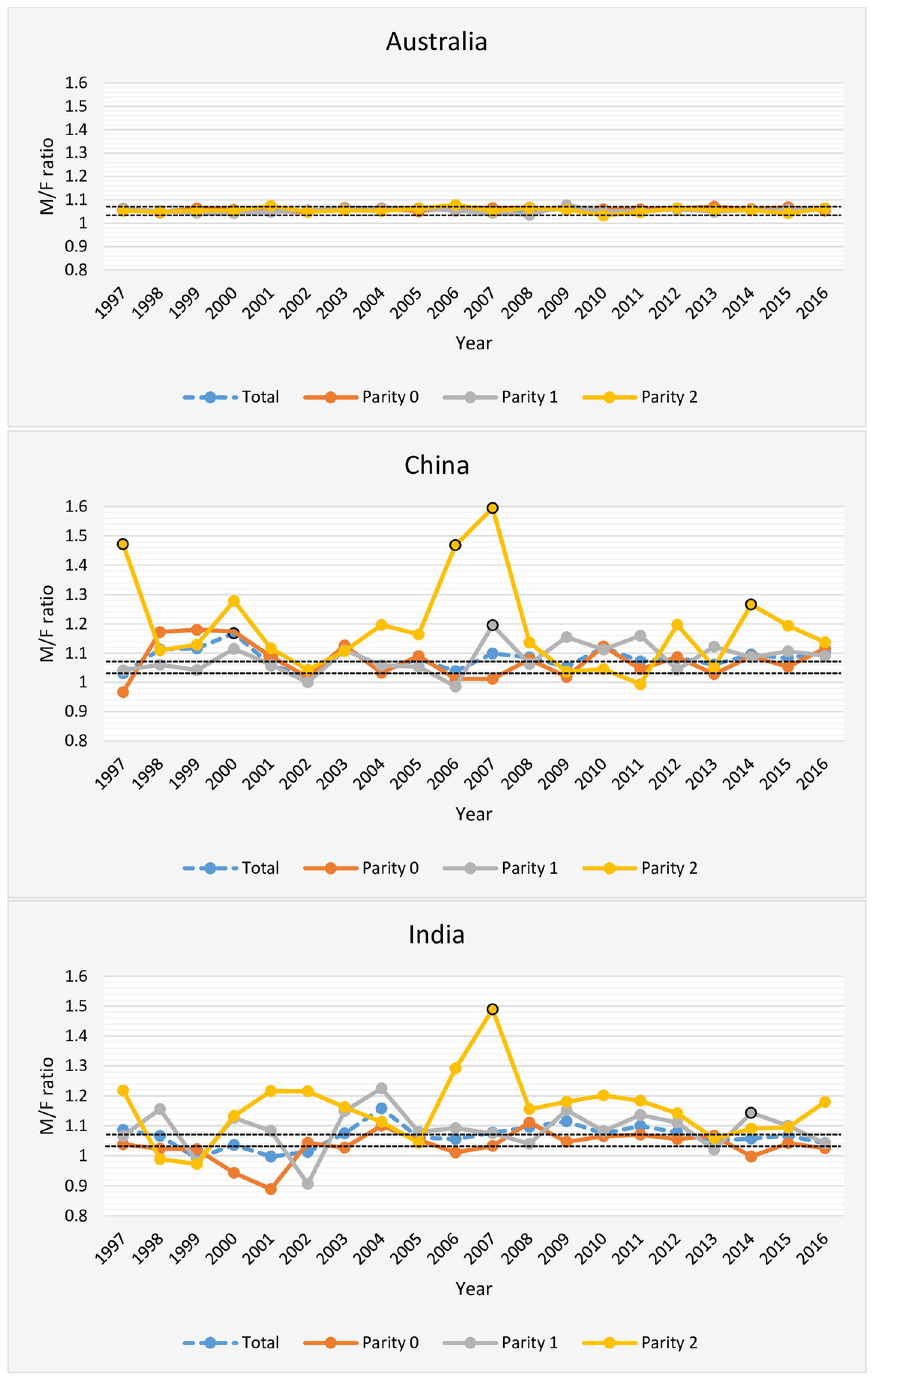
Fig 2. Male-to-female ratio trends by parity 1997–2016.